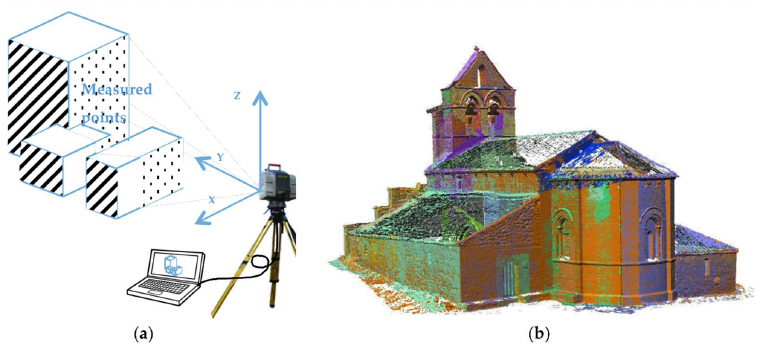
Figure 2. ( a ) Laser scanning process to create a point cloud; ( b ) Georeferenced point cloud, (X, Y, Z). Source: Own figures.